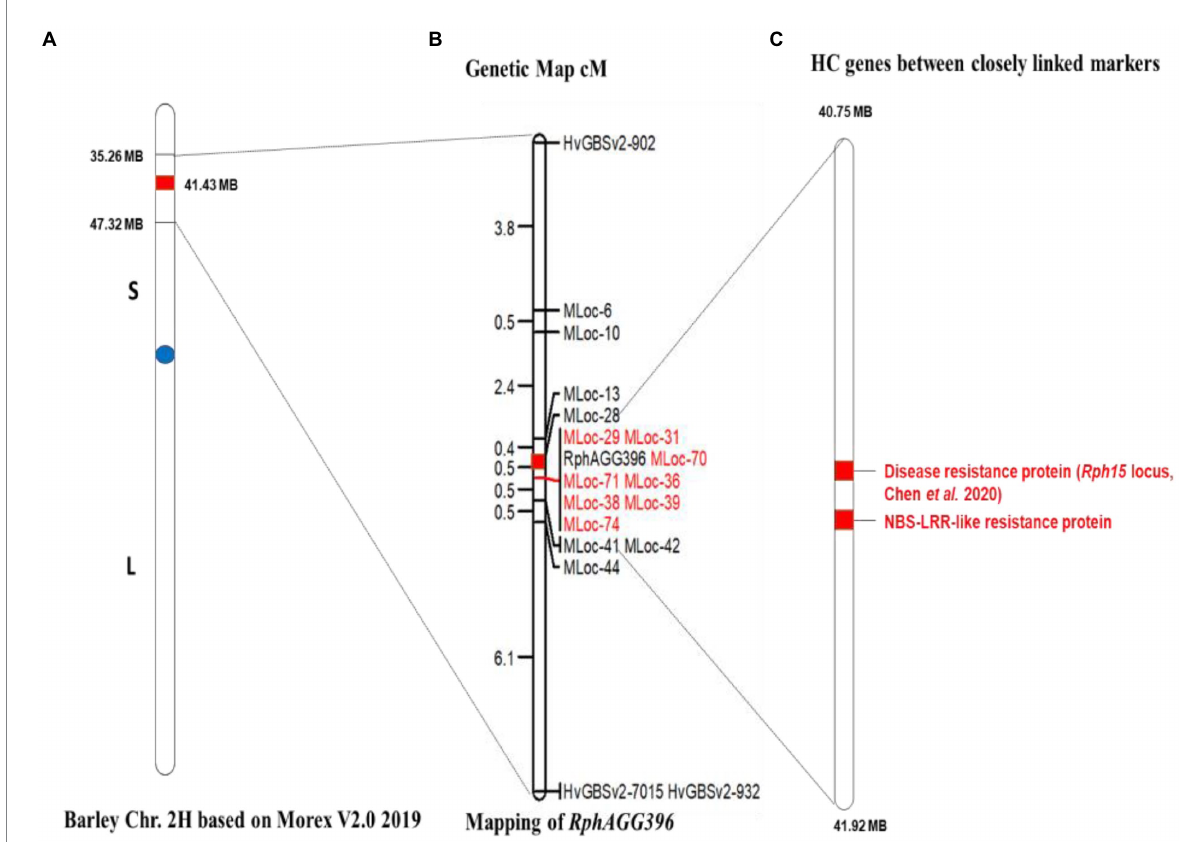
FIGURE 5 Genetic and physical map for RphAGG396 based on the Morex genome assembly 2019 (v2). (A) Barley chromosome 2H showing the physical window between 35 and 47 Mb for RphAGG396 based on polymorphic KASP and CAPS markers, (B) fine map of RphAGG396 placing the locus between MLoc-28 and MLoc-41 within a physical interval of 1.17 Mb. Markers co-segregating with RphAGG396 are highlighted red (C) predicted NLRs genes (red highlighted) between MLoc-28 and MLoc-41.